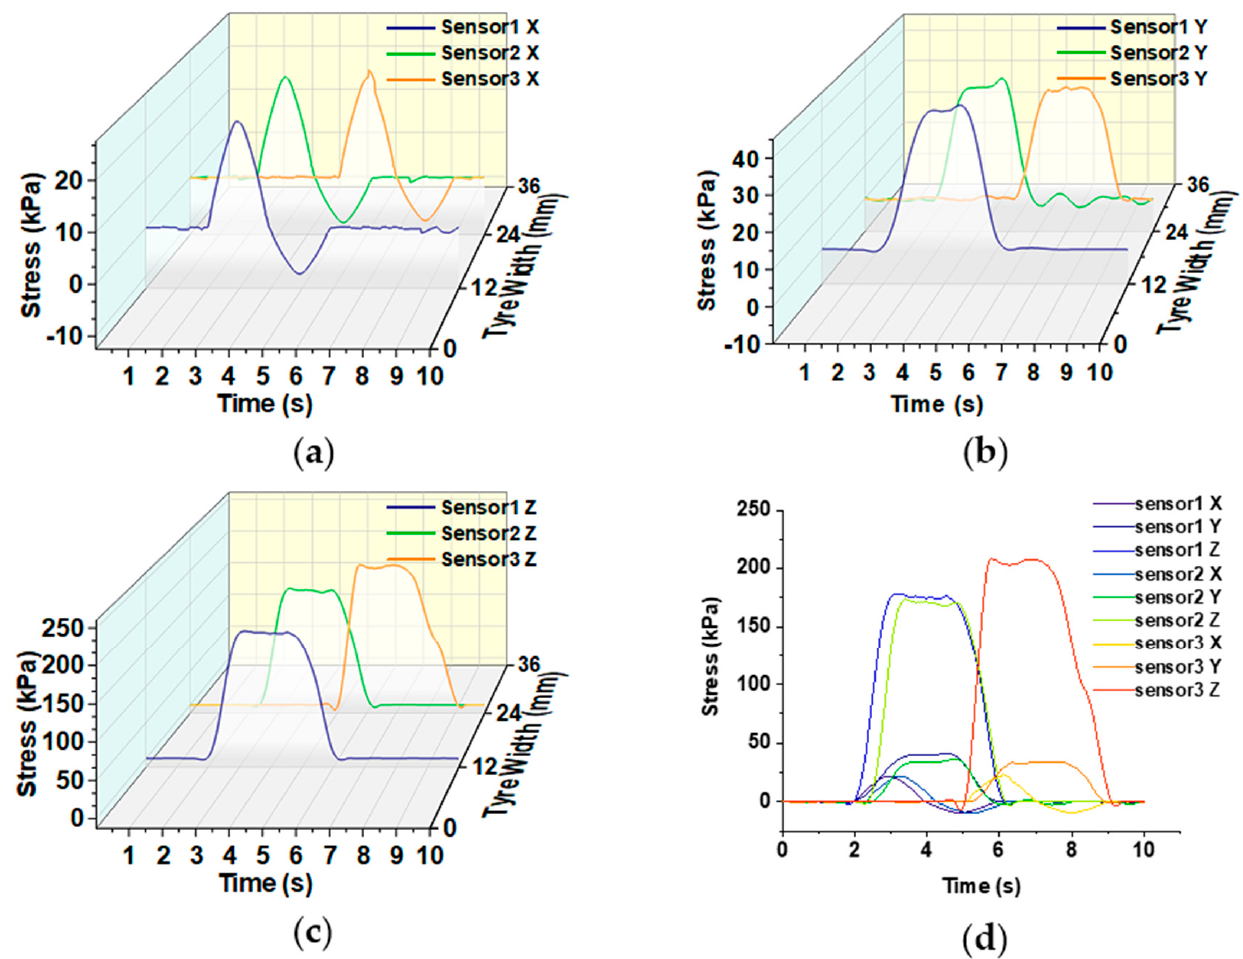
Figure 9. Relationship between time and stress: ( a ) variation of stress in X direction with time; ( b ) variation of stress in Y direction with time; ( c ) variation of stress in Z direction with time; ( d ) time- dependent stress of all transducers.